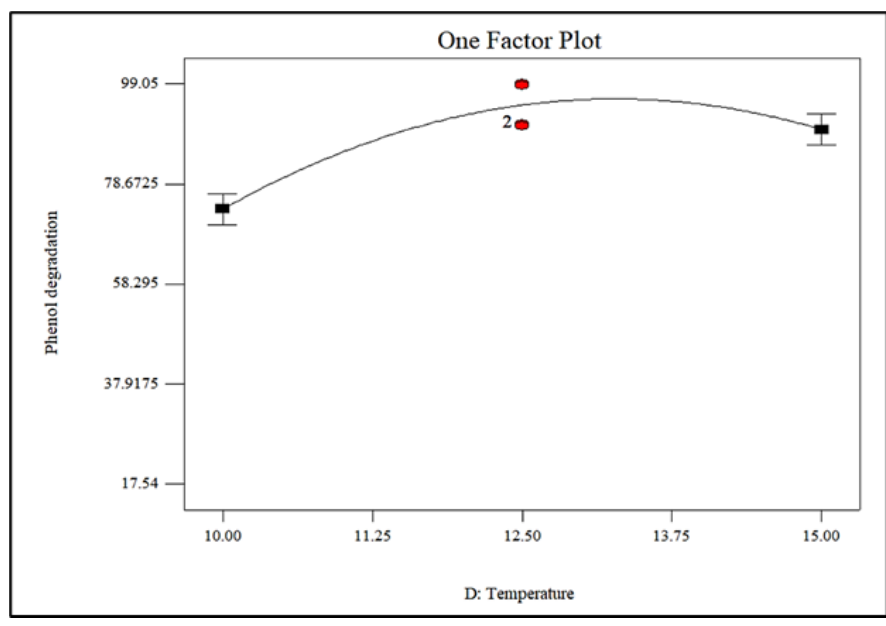
Figure 2. The one-factor plot showing the significant effect of temperature on phenol degradation by the binary consortium. the binary